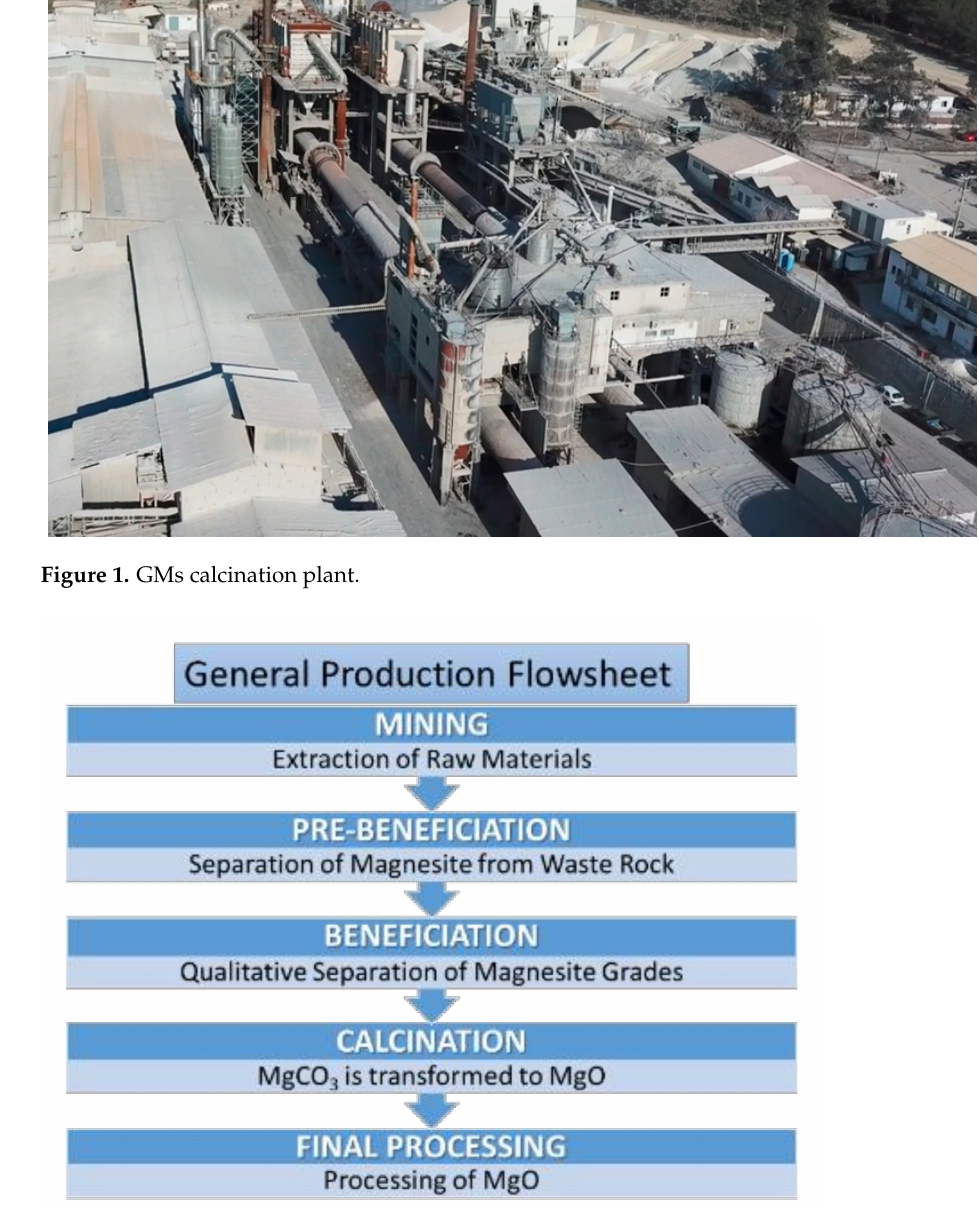
Figure 2. GM’s general production